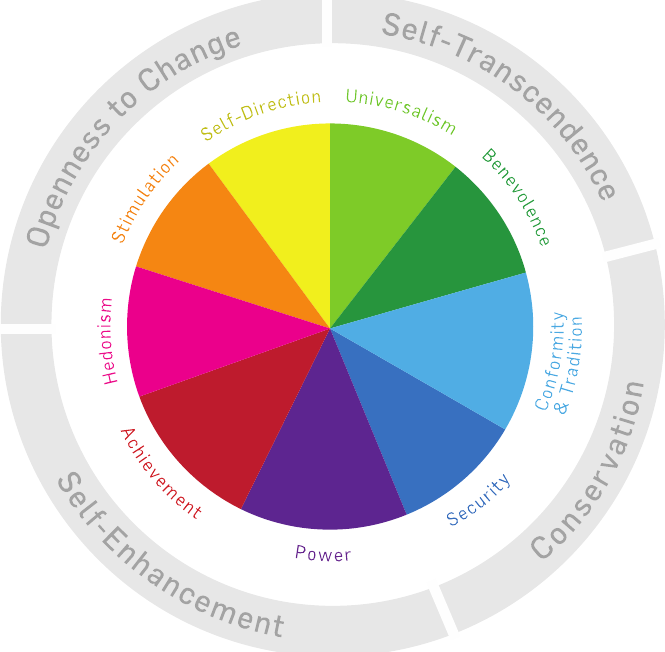
Figure 1: Schwartz value